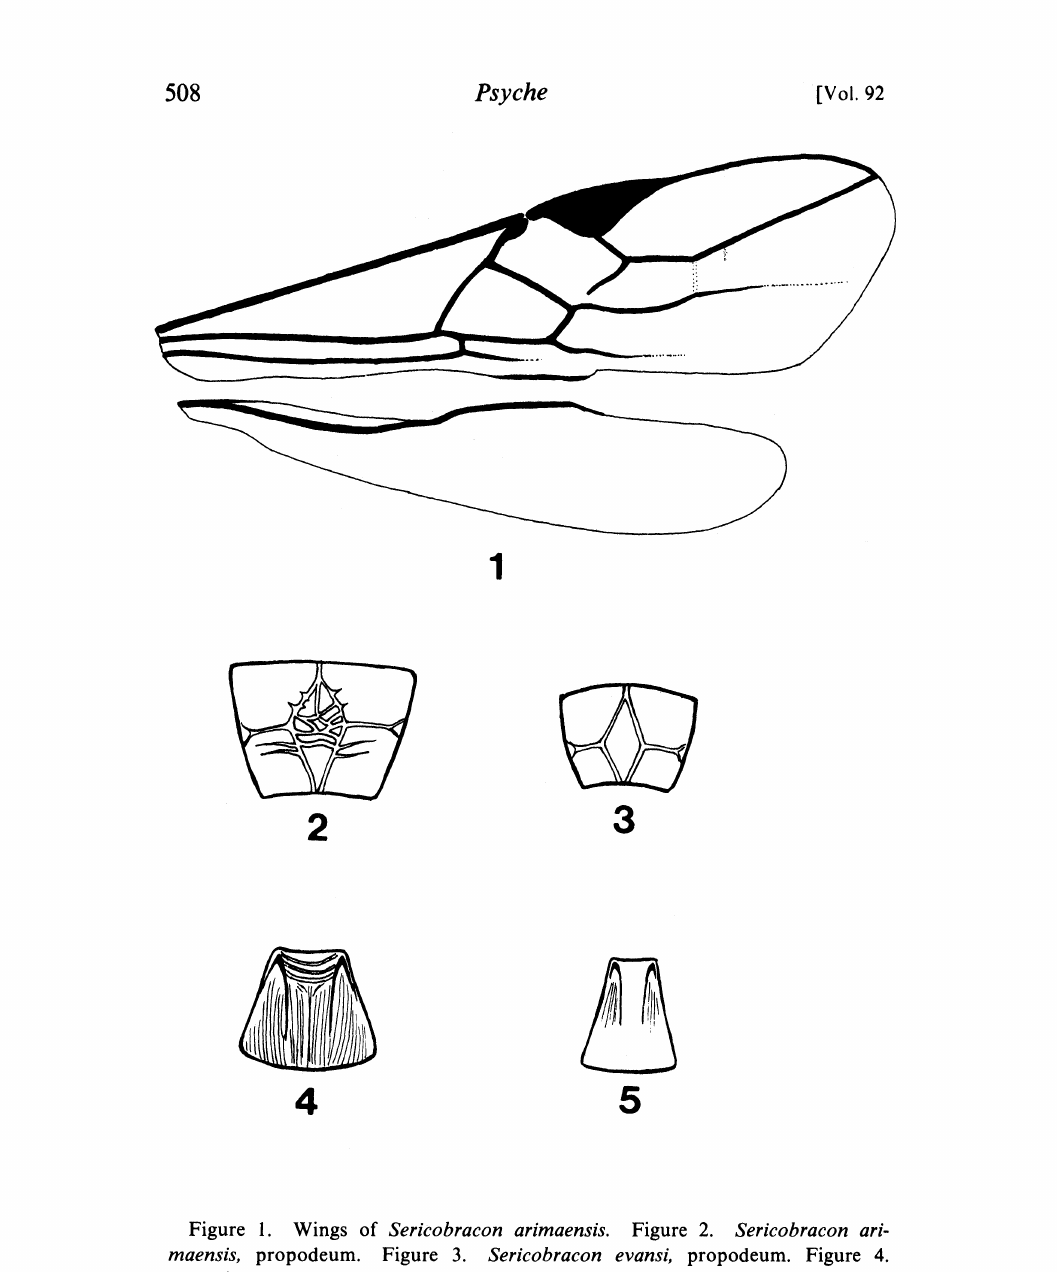
Figure 1. Wings of Sericobracon arimaensis. Figure 2. Sericobracon ari- maensis, propodeum. Figure 3. Sericobracon evansL propodeum. Figure 4. Sericobracon arimaensis, tergum 1. Figure 5. Sericobracon evansL tergum